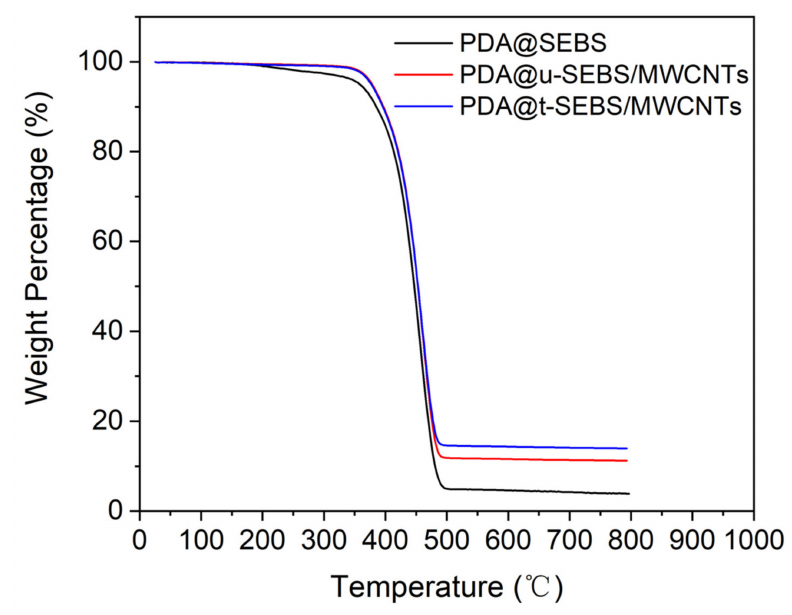
Figure 3. TGA curves of PDA@SEBS, PDA@u-SEBS/MWCNTs and